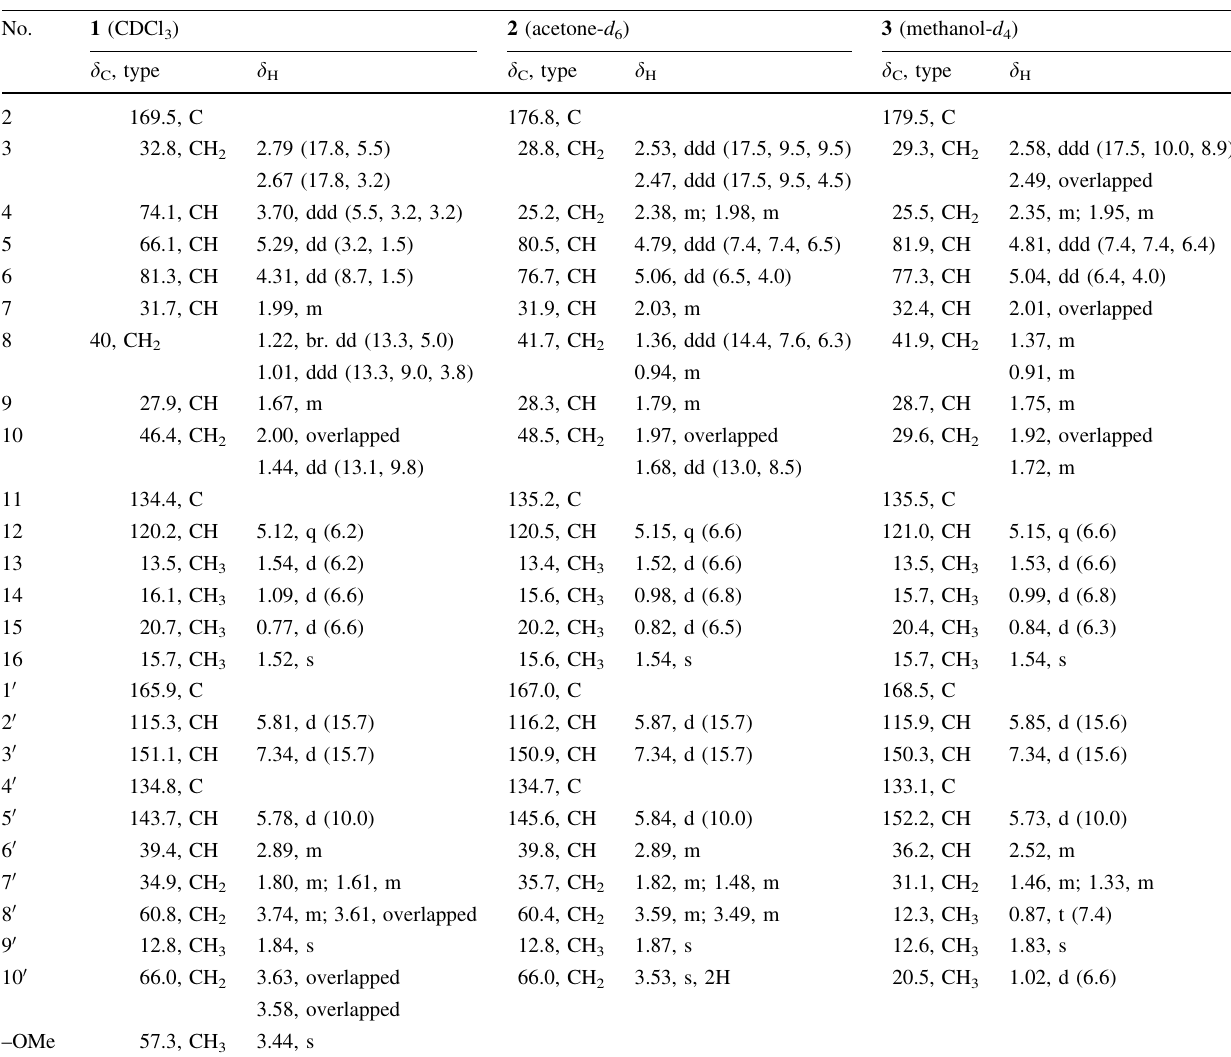
Table 1 1 H (600 MHz) and 13 C (150 MHz) NMR spectroscopic data of 1 – 3 ( d in ppm, J in Hz)